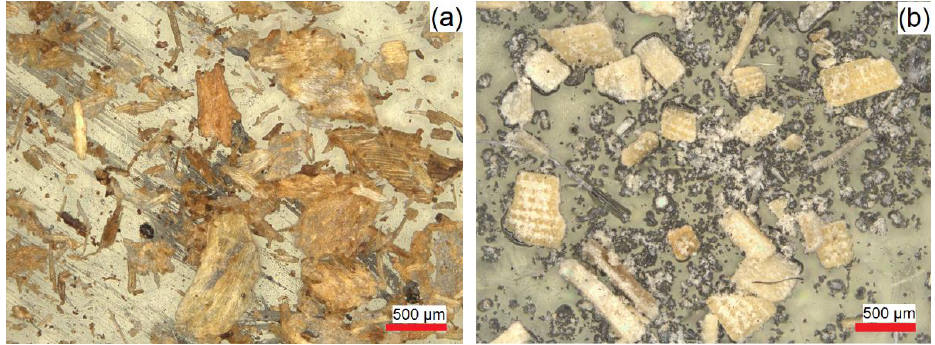
Figure 3. Optical images of the biofillers: ( a ) coffee chaff; ( b ) rice hull.